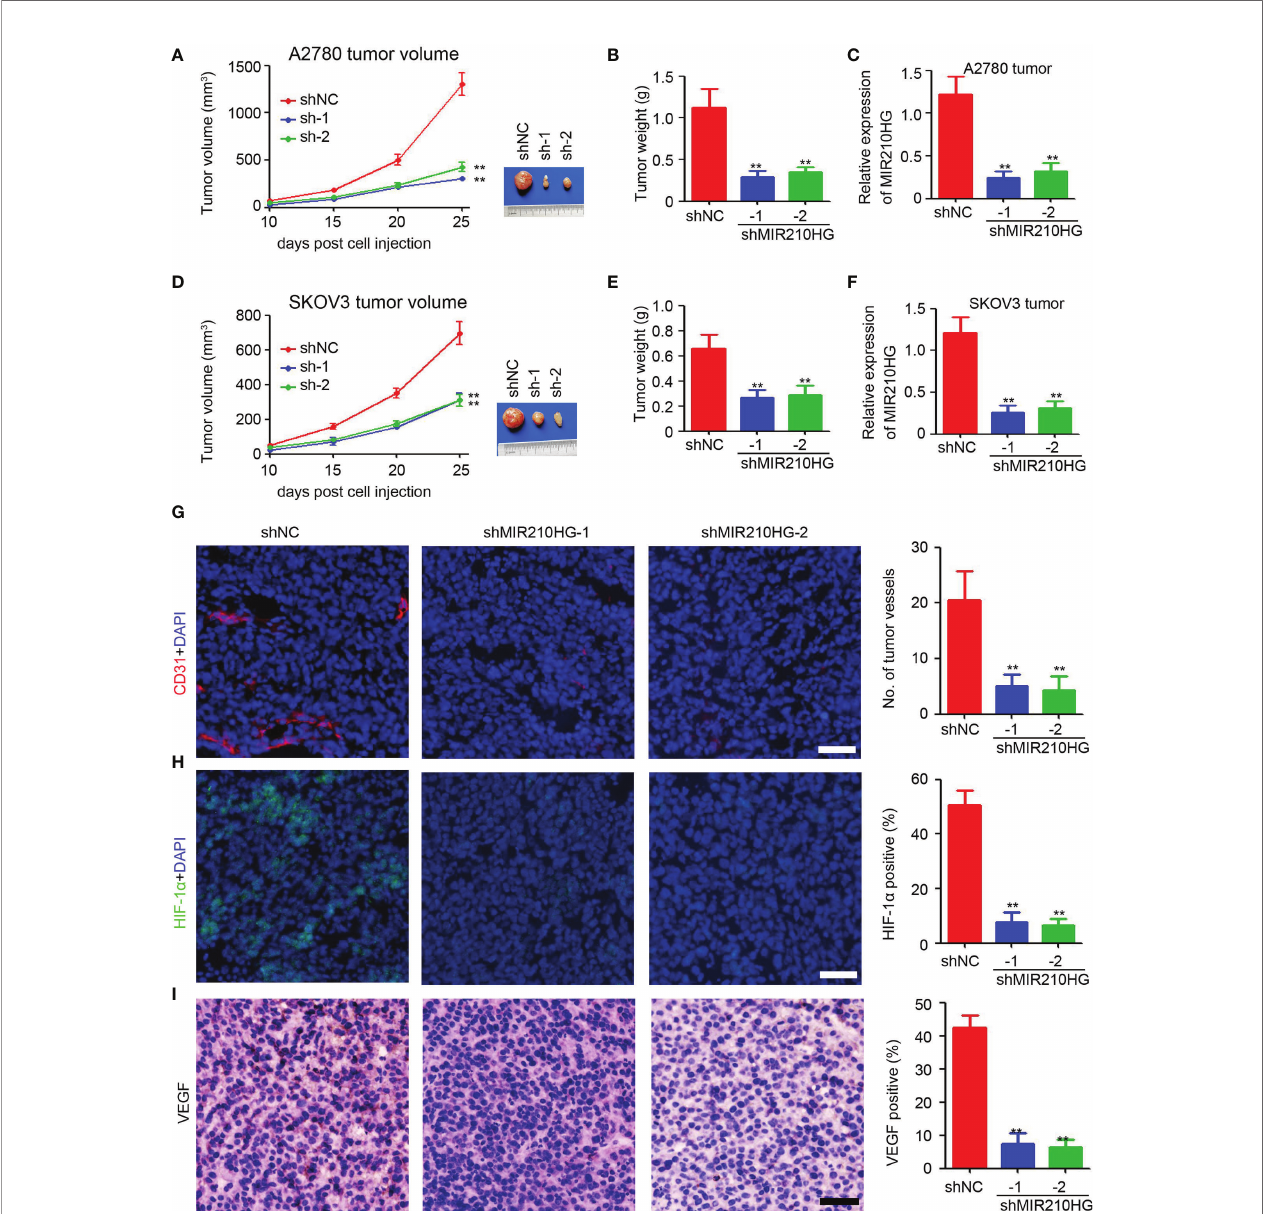
FIGURE 5 | Knockdown of lncRNA-MIR210HG inhibits tumor growth in mice. (A) A2780-shNC and A2780-shMIR210HG cells were injected into nude mice to establish subcutaneous tumor model. Tumor volume was measured every 5 days and the tumor growth curve was performed (n = 5, **p < 0.01). (B) Tumor weight of A2780-shNC and A2780-shMIR210HG tumors (n = 5, **p < 0.01). (C) qPCR analysis of lncRNA-MIR210HG expression in A2780-shNC and A2780-shMIR210HG tumors (n = 3, **p < 0.01). (D) SKOV3-shNC and SKOV3-shMIR210HG cells were injected into nude mice to establish subcutaneous tumor model. Tumor volume was measured every 5 days and the tumor growth curve was performed (n = 5, **p < 0.01). (E) Tumor weight of SKOV3-shNC and SKOV3-shMIR210HG tumors (n = 5, **p < 0.01). (F) qPCR analysis of lncRNA-MIR210HG expression in SKOV3-shNC and SKOV3-shMIR210HG tumors (n = 3, **p < 0.01). (G) Detection of tumor angiogenesis in A2780-shNC and A2780-shMIR210HG tumors by CD31 staining. Cell nucleus was stained with DAPI. The number of tumor vessels was analyzed (n = 3, **p < 0.01, Scale bar = 100 m m). (H) Detection of HIF-1 a in A2780-shNC and A2780-shMIR210HG tumors by immuno fl uorescent staining. Cell nucleus was stained with DAPI. The percent of HIF-1 a positive cells was analyzed (n = 3, **p < 0.01, Scale bar = 100 m m). (I) Detection of VEGF in A2780-shNC and A2780-shMIR210HG tumors by IHC staining. The percent of VEGF positive cells was analyzed (n = 3, **p < 0.01, Scale bar = 100 m